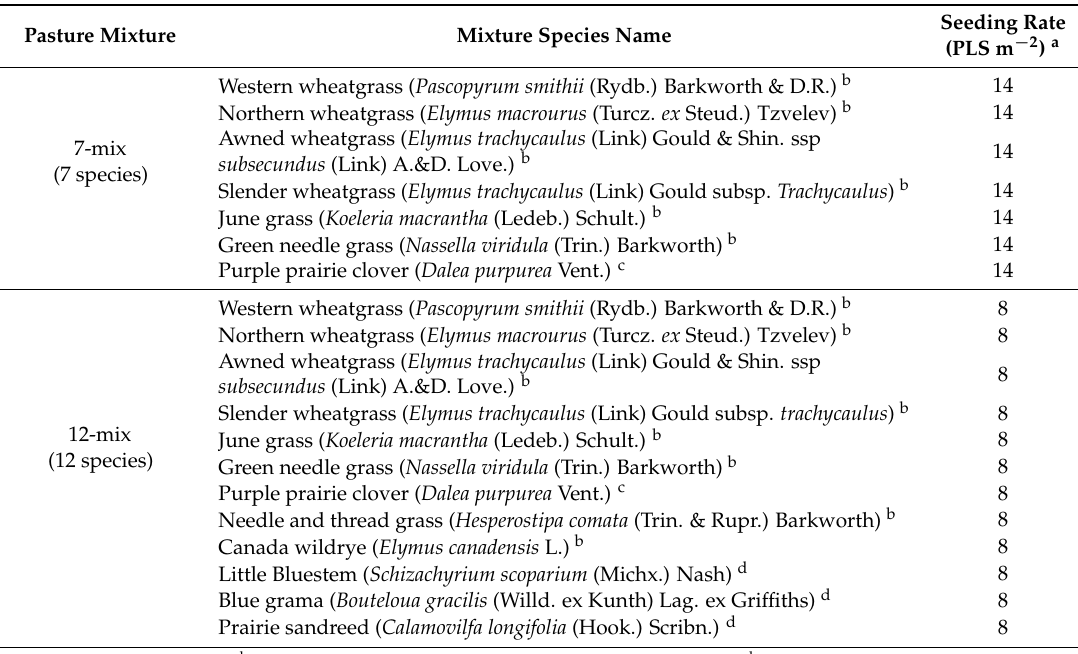
Table 1. Species name of the two native plant mixtures and seeding rate of each species. Pasture